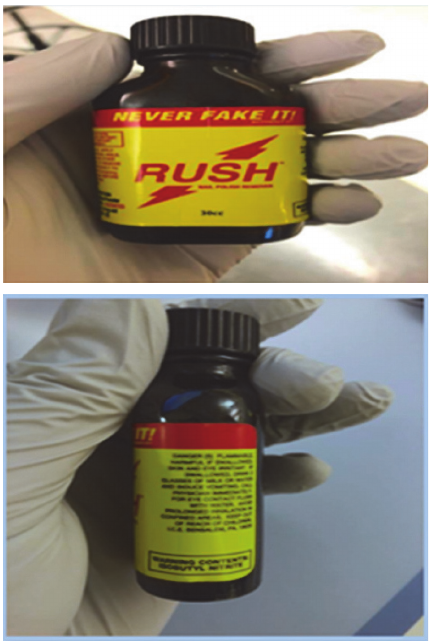
Figure 1: “Rush” nail polish remover.